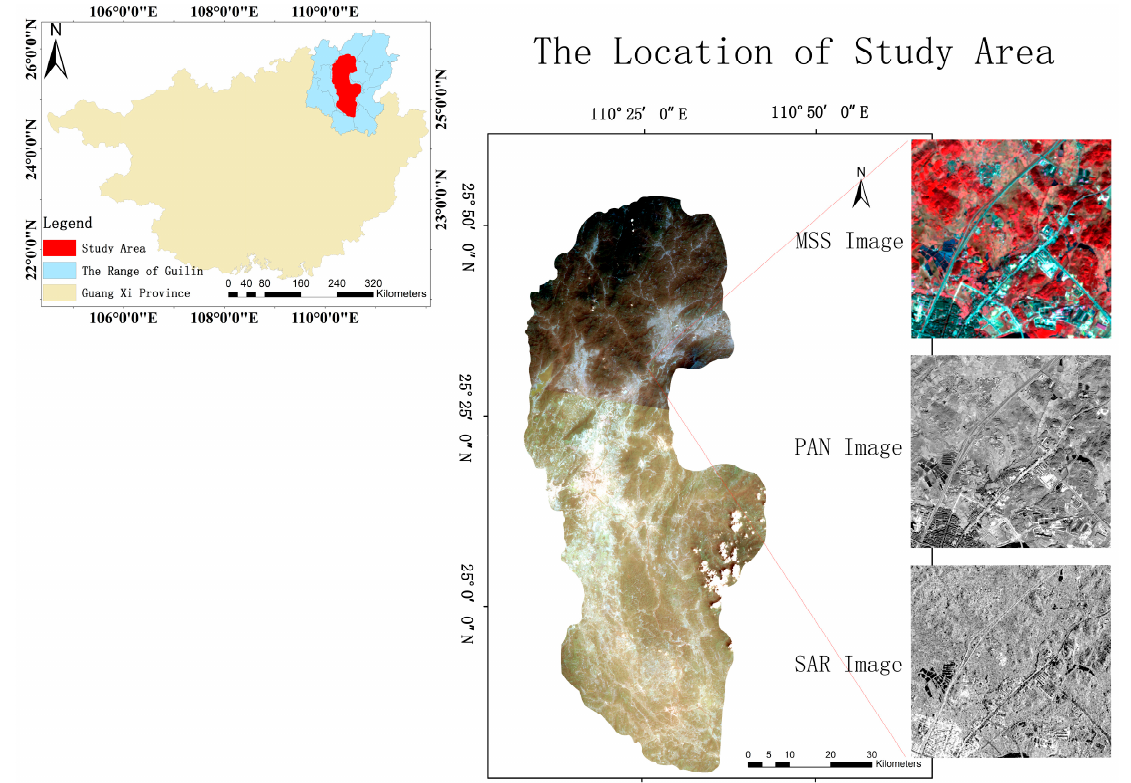
Figure 1. Location of study area which is located within the region 24°38 ′ –25°54 ′ N, 110°09 ′ –110°46 ′ E. SAR: synthetic aperture radar. N: northern latitude. E: east longitude.